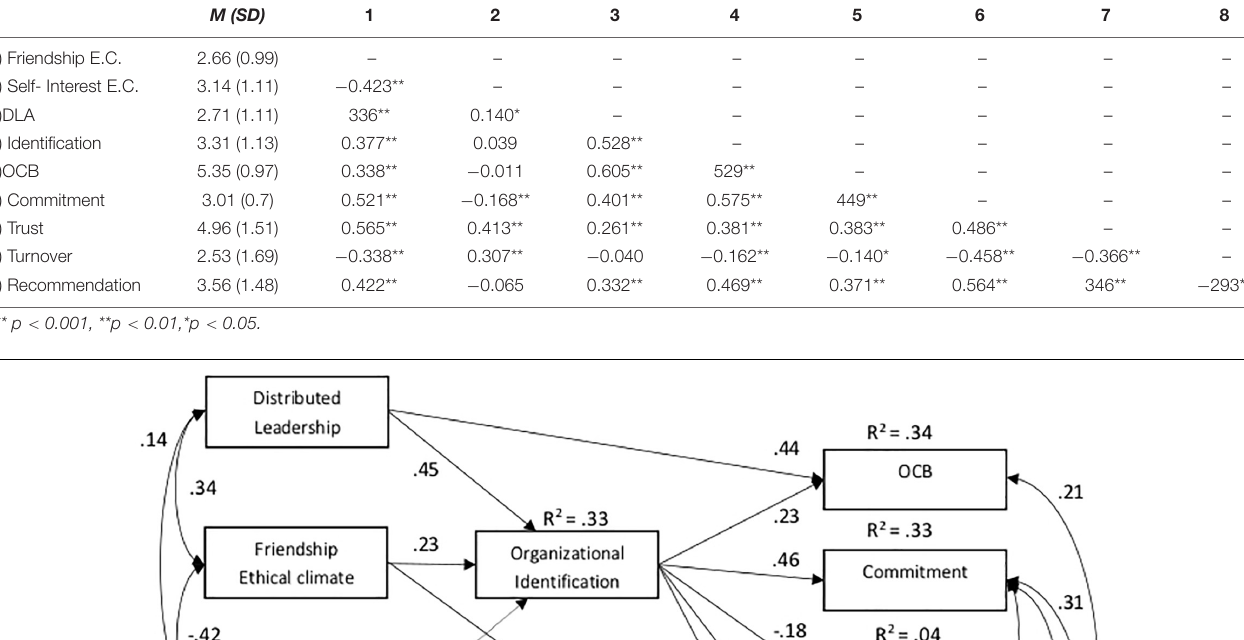
TABLE 1 | Descriptive statistics and zero-order correlations among the variables of the study.